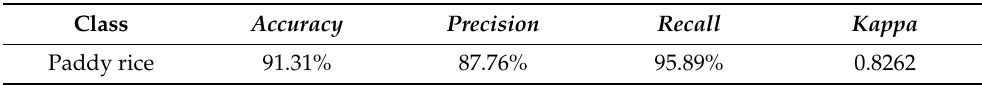
Table 4. The accuracies of Thailand paddy rice mapping